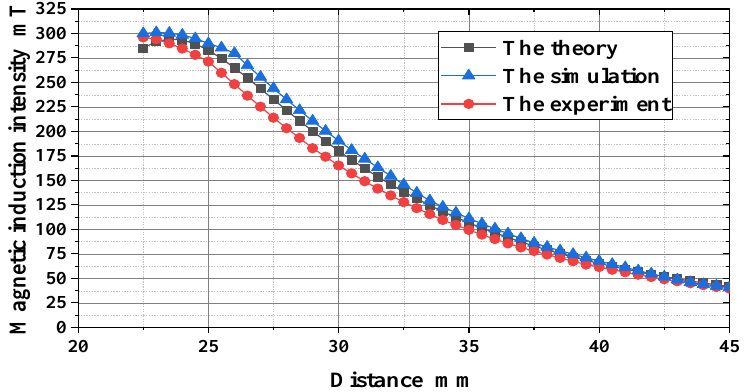
Figure 9. Comparison of simulation and experimental results.